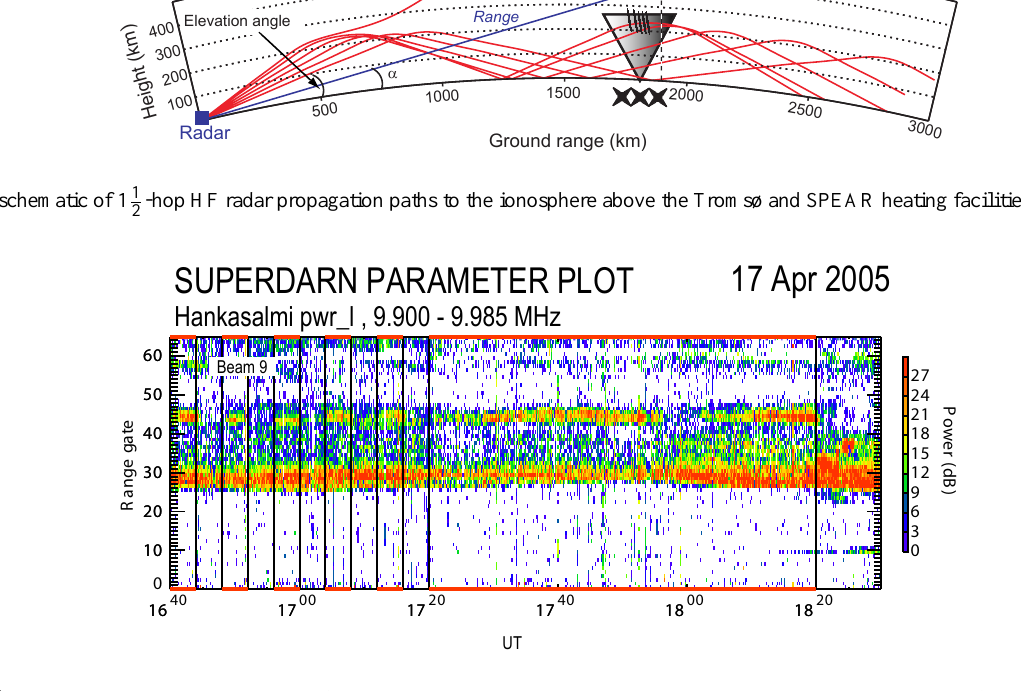
Fig. 3. (a) A range gate-time representation of backscatter power measured by the Hankasalmi radar during a period of SPEAR high power operations on 17 April 2005. Backscatter power is color-coded according to the bar to the right of the panel. SPEAR O-mode operations are indicated by vertical black lines and red horizontal lines at the top and bottom of the panel. Intervals of strong backscatter centred on range gate 45 can be seen when SPEAR is